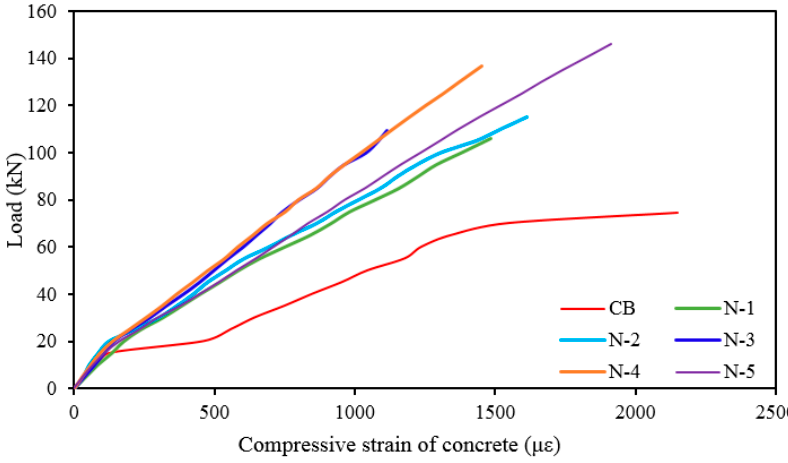
Figure 6. Load vs. compressive strain of concrete at midspan for all beams.